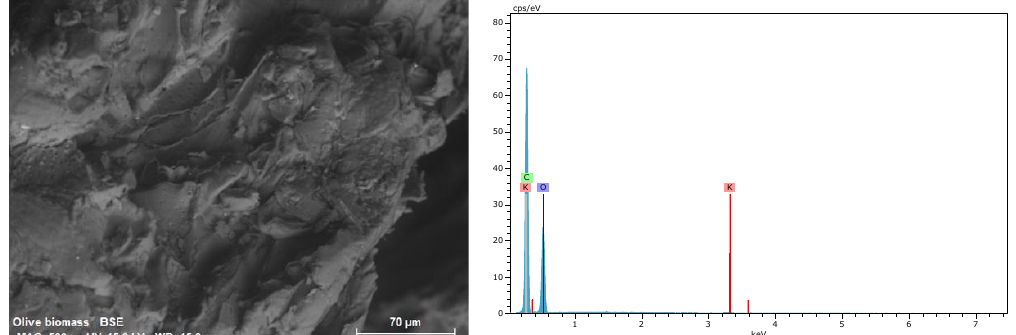
Figure 3. SEM image and EDS analysis of olive-mill residue biomass.